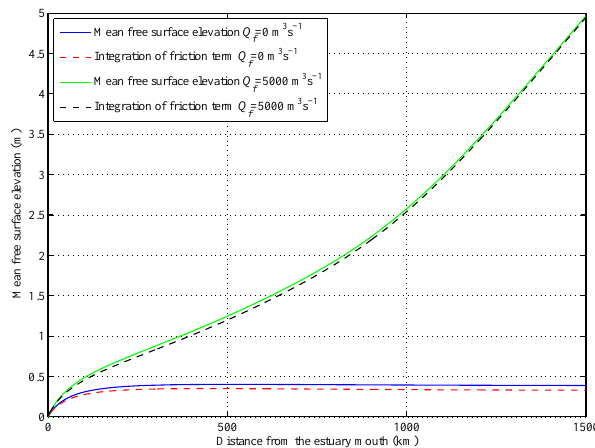
Fig. 3. Tidally averaged free surface elevation calculated from the numerical model (solid lines) and evaluated through Eq. (26) both with and without river discharge for given values of K =60m 1 / 3 s − 1 , b =352km, ζ 0 =0.2, h =10m, B 0 =5000m, B min